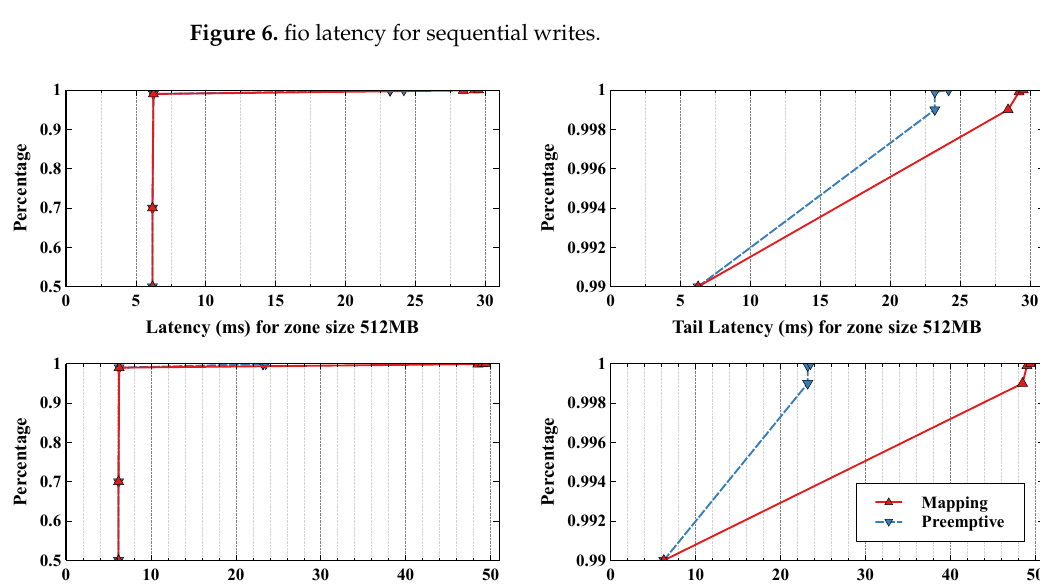
Figure 7. fio latency for random